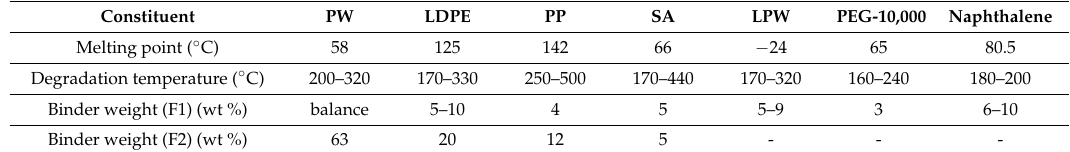
Table 1. Characteristics of pure components and the compositions of the binders.